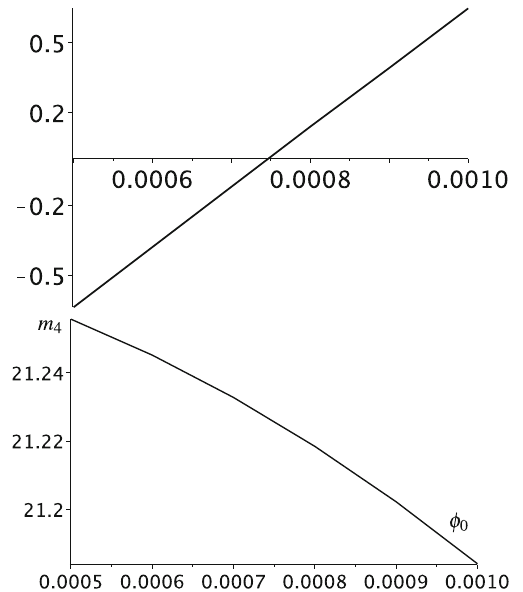
Fig. 9 The dependence of Λ 4 and m 4 on φ 0 for f ( R ) = aR 2 + bR + c and m D = 1 , m = 0 . 1 , b = 1 , a = − 100 , c = − 0 . 0021 , V (φ) = ( m 2 / 2 )φ 2 , H = 0. R ( 0 ) is the positive root of